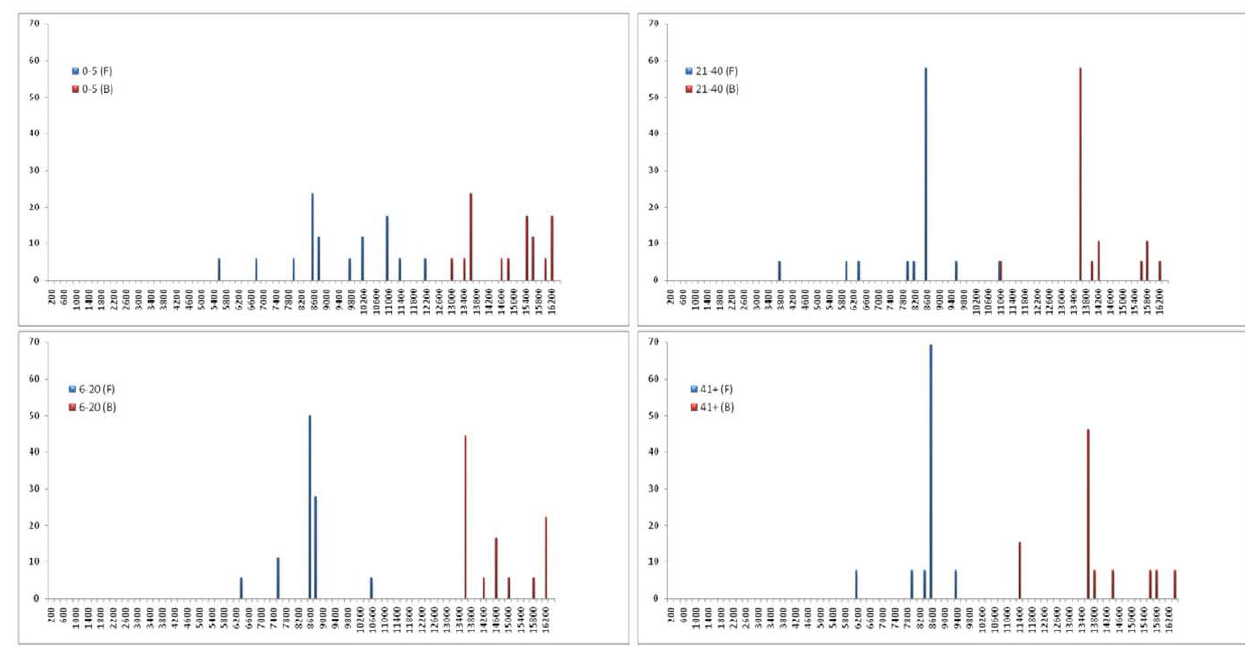
Figure 2. Breakpoint distribution in age-grouped mtDNA deletion patients. X-axis represents the nucleotide position along the mitochondrial genome in 200 nucleotide increments, and y-axis represents the percentage of samples with that breakpoint in BP1 and BP2 to the total number of breakpoints in BP1 and BP2 respectively (BP1 and BP2 refer to the breakpoint locations rounded to the next 200 nt increment).